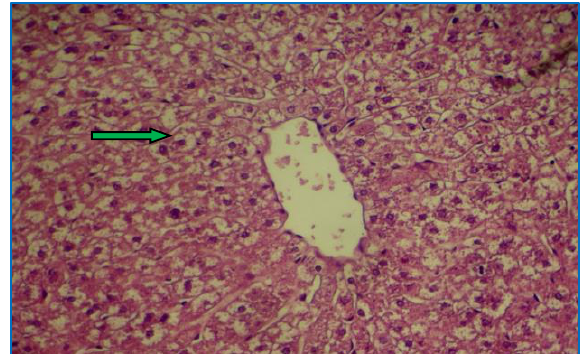
Figure, 12: G6: Liver of rabbits at 30 days post infection showing restoration of hepatic tissue to nearly normal picture with hydropic degeneration of hepatocytes ( ) (H and E